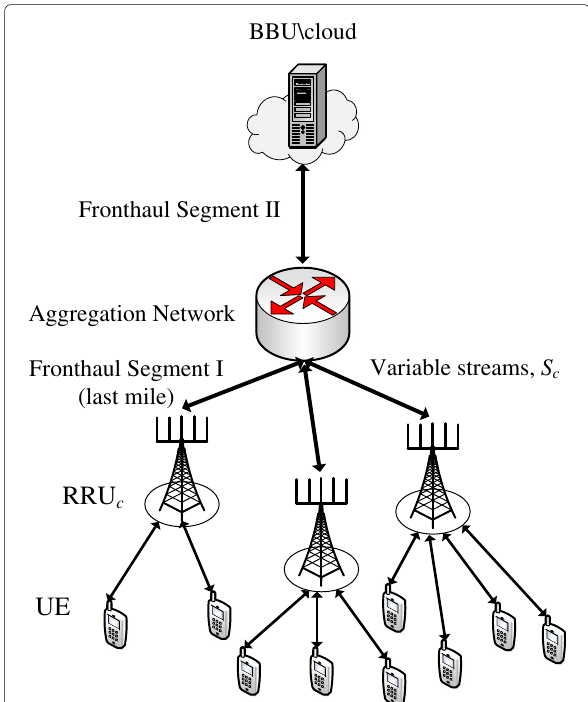
Fig. 1 C-RAN network. Massive MIMO-based C-RAN deployment with two fronthaul segments and statistical